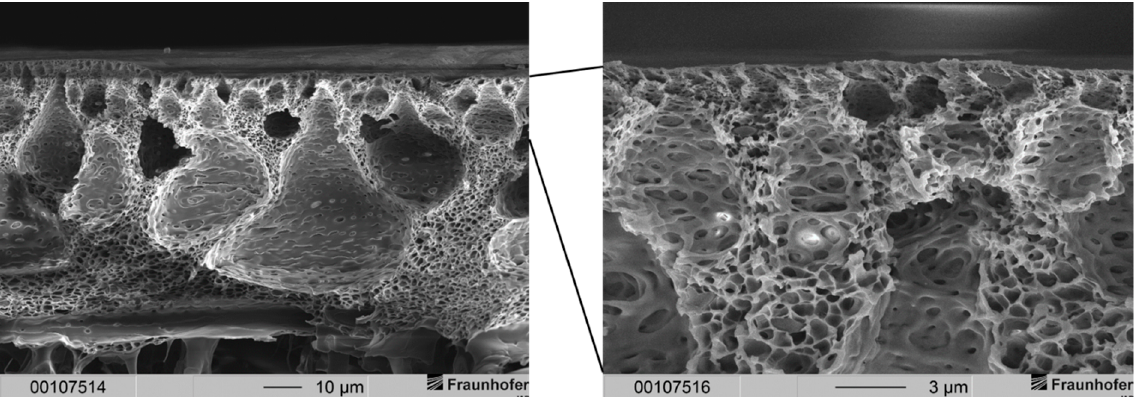
Figure 5. ( Left ) Cross-section of an integrally skinned PSU flat sheet membrane without PDMS protective layer. The PSU concentration was increased to 25 wt.-%. The solvent ratio was kept constant. The precipitation medium used was distilled water. ( Right ) Enlarged view of the top layer with dense separation layer.